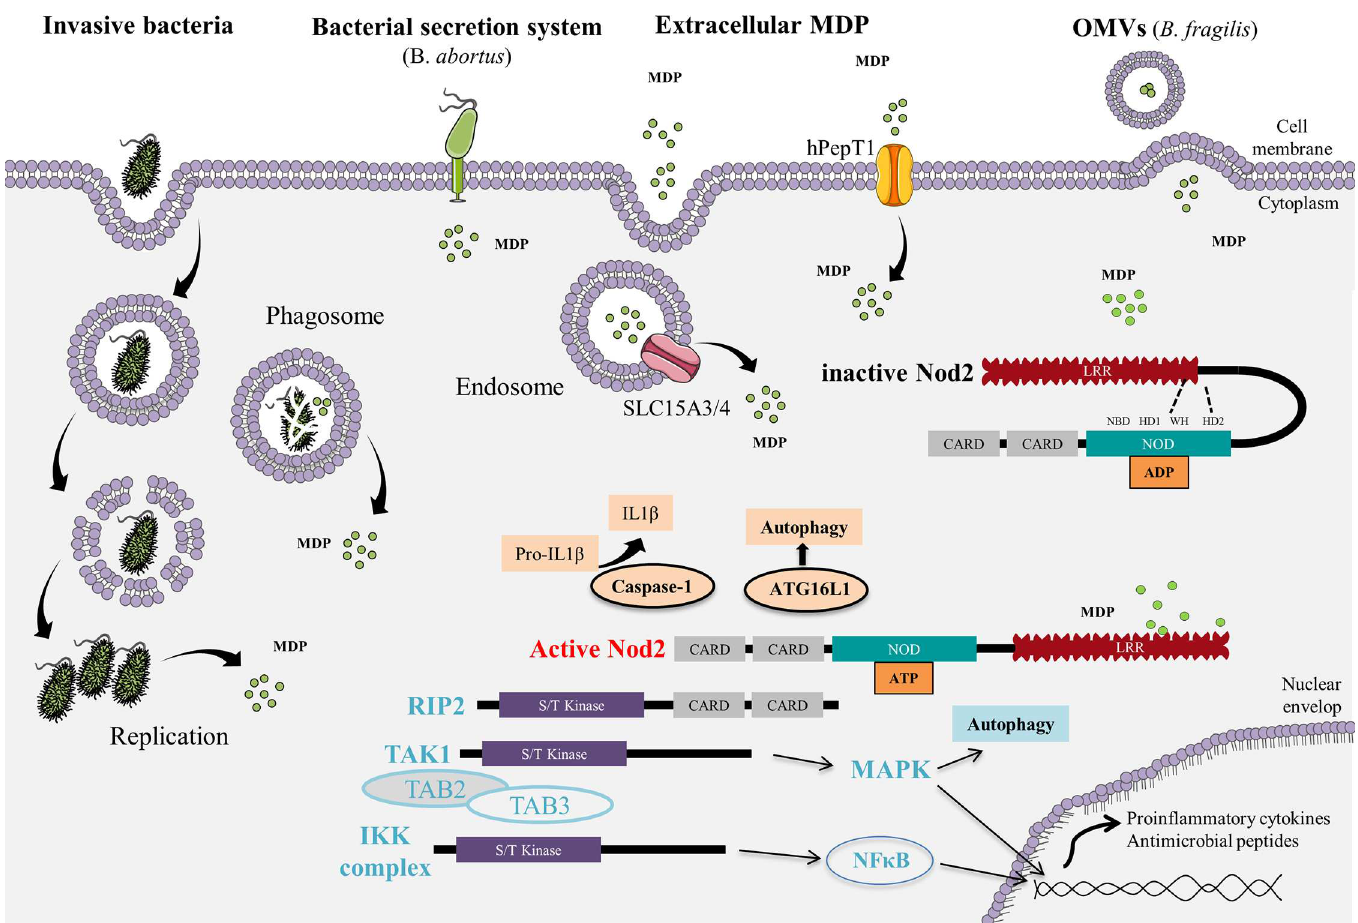
Fig 1. Mechanismsby which MDP enters into cells to trigger Nod2 signaling. Several routes of MDP entry have beenevidenced.Host cells can internalizeMDP through either phagocytosis of wholebacteria, endocytosis, uptakingof PGN fragments from OMVs, or transmembrane channels such as hPepT1. A new way of Nod2 activationinvolvingthe entry of MDP via the apparatussecretionsystem of bacteria has recently been described.NOD2 activationrequiresits location to be in the vicinity of the site of MDP delivery. Two peptidetransporters (SLC15A3and SLC15A4) are able to translocate MDP toward the cytosolic compartment. NOD2 protein exhibits three domains,including caspase activationand recruitment domains(CARDs), nucleotide- bindingoligomerization domain (NOD), and leucine-rich repeat (LRR). The NOD modulecontainsa nucleotide-binding domain(NBD), a wingedhelix (WH), and two helix domains(HD1 and HD2). The interactionbetweenNBD and WH, important to stabilizeNod2 in an inactive form, is maintained by adenosine diphosphate (ADP)-mediated packed conformation. Upon ligandbinding,HD2 mediatesconformational changesof the NBD, WH, and HD1 to allow ADP-ATP exchange,self-oligomerization, and downstreamsignaling. The effector CARDs mediateintracellularsignalingafter interaction betweenthe LRR domainand MDP. NOD2 oligomerization induces a signaling complex namednodosome.NOD2 attracts receptor-interacting serine/threonine-proteinkinase 2 (RIP2) via a CARD–CARD homotypicinteraction, followedby transforming growth factor beta-activated kinase 1 (TAK1) and TAK1 bindingproteins2 and 3 (TAB2 and TAB3). This complex inducesthe activationof both MAPKs and NF- κ B pathways. The interaction of NOD2 with other partners, includingCaspase- 1 and ATG16L1, results in IL-1 β secretionand autophagy,